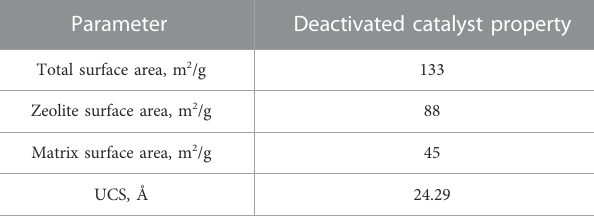
TABLE 2 Steam deactivated catalyst properties.